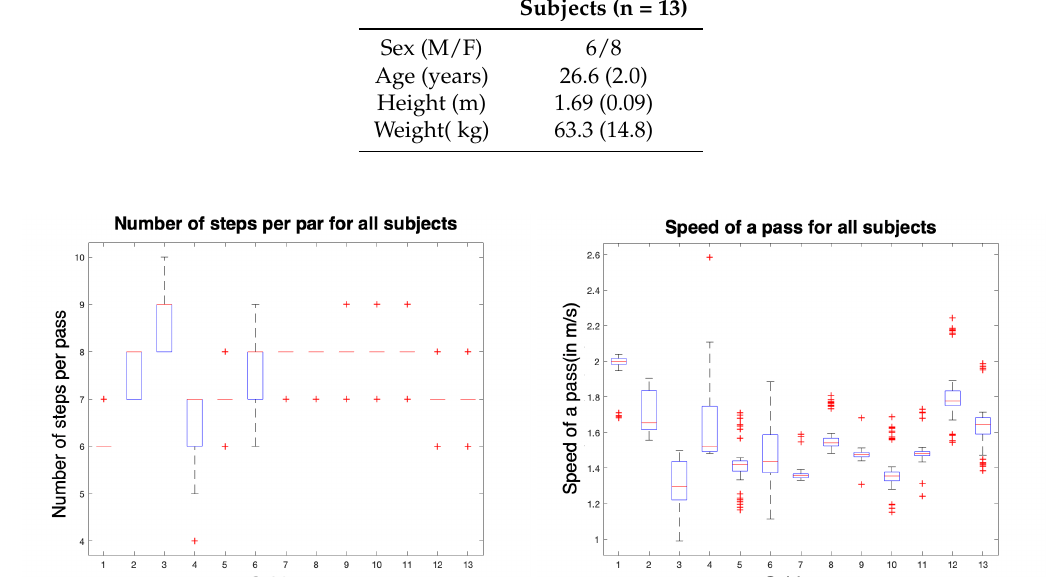
Figure 6. Box plots of the number of steps and the walking speed per